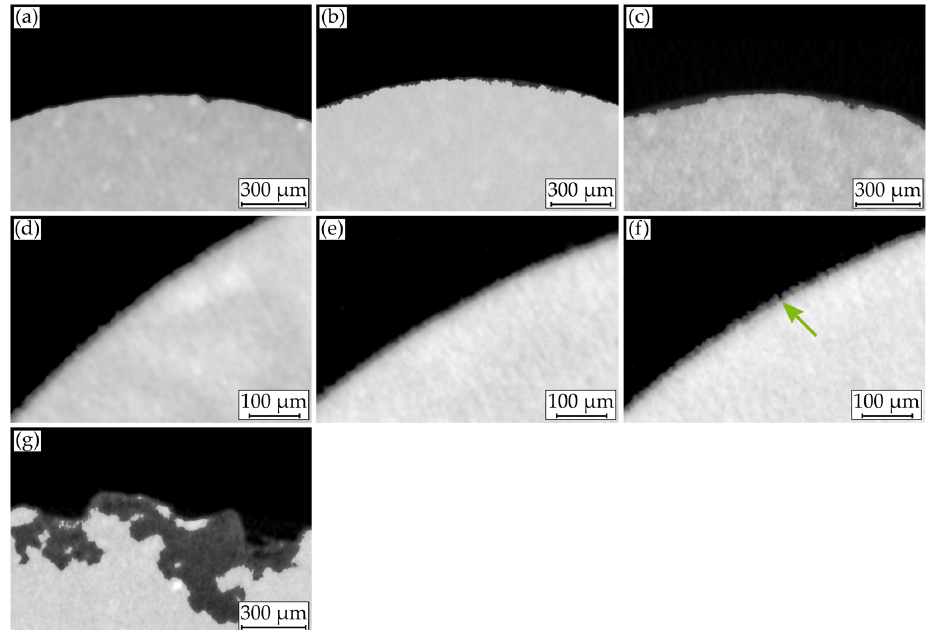
Figure 10. µ-computed tomography images after immersion tests without galvanostatic anodic polarization of WE43 ( a – c , g ) and WE43 PEO ( d – f ): ( a , d ) 1 week; ( b , e ) 2 weeks; ( c , f , g ) 3 weeks.